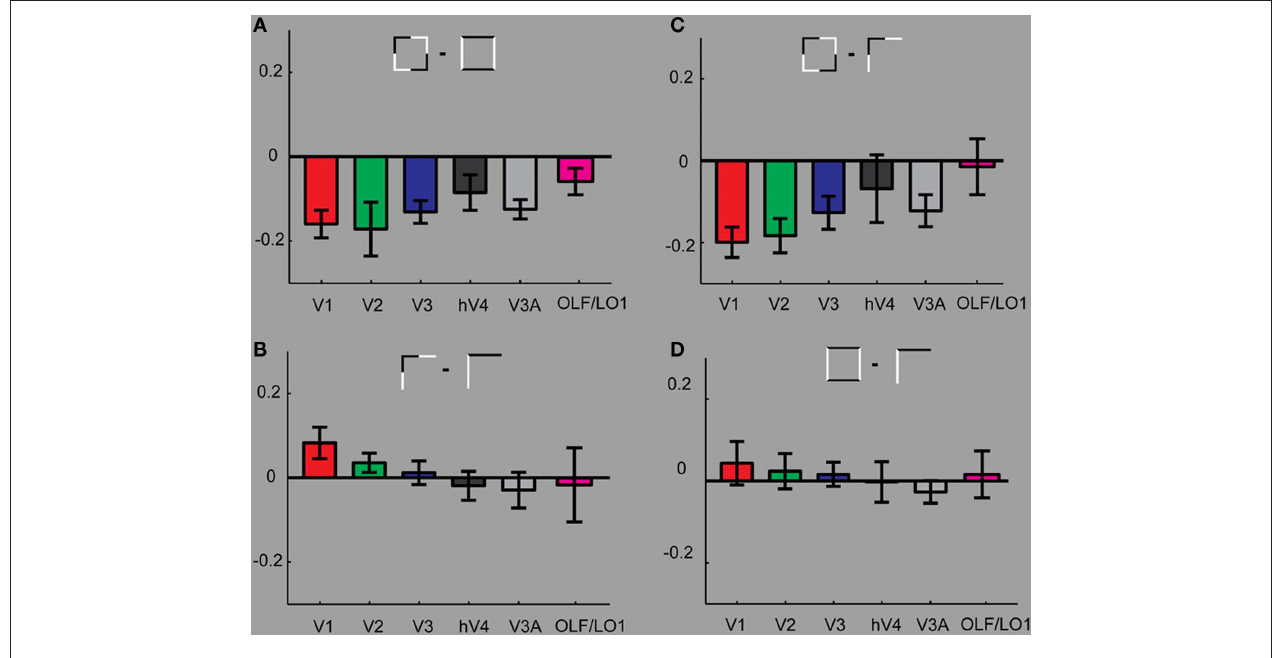
all other ROIs the responses to the valid and non-valid junction patterns are almost identical. (C) The strongest response differences result comparing the two collinear conditions. (D) Comparing the two intersecting control conditions reveals no difference, confirming that comparing the two collinear conditions is meaningful and not confounded by strong effects from simple stimulus properties such as number of elements and